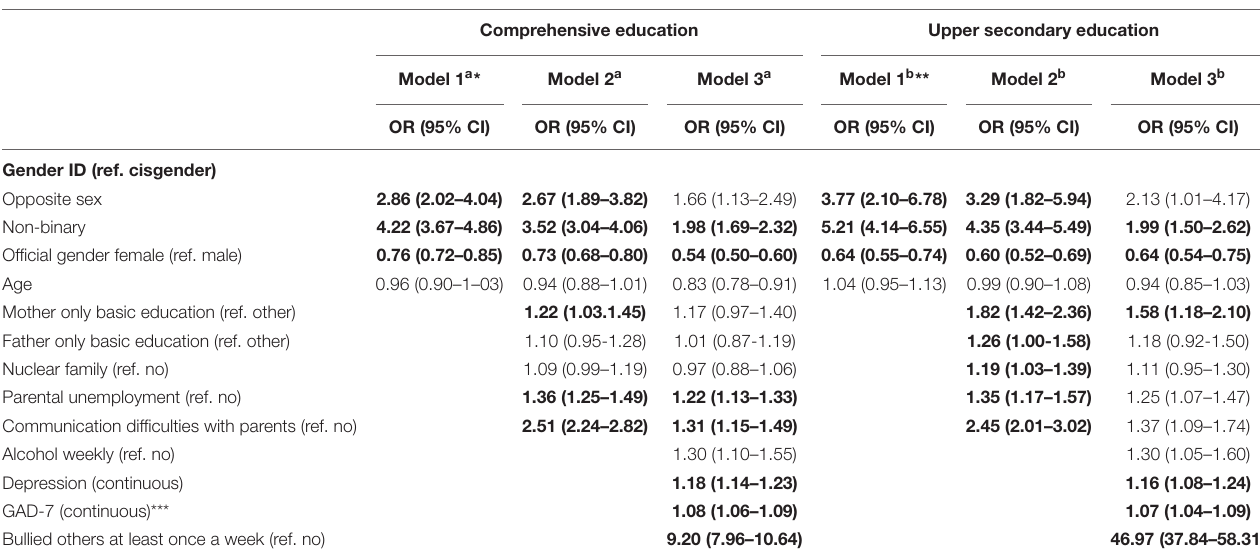
TABLE 3 | Regression analysis of being